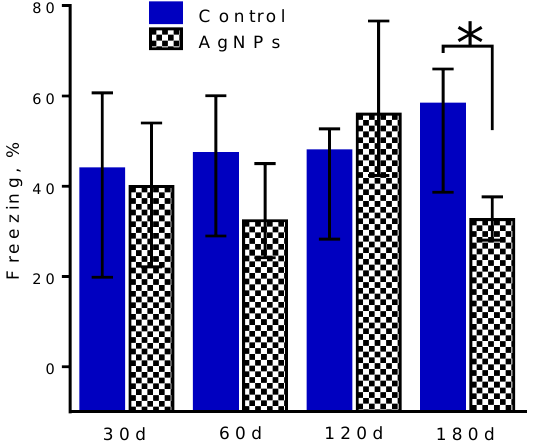
Figure 6. Impairment of long-term contextual fear memory in Ag-NP-exposed mice in the ‘180 days’ group tested 24 h after training. The daily exposure dose was 50 µ g per animal. The level of freezing was significantly lower among mice in the ‘FC’ Ag-NP-exposed group than among the ‘FC’ control group. This effect was not observed in the other groups. Data are represented as the median ± interquartile range. * p < 0.05; nonparametric Mann-Whitney test ( n = 6–8 animals per